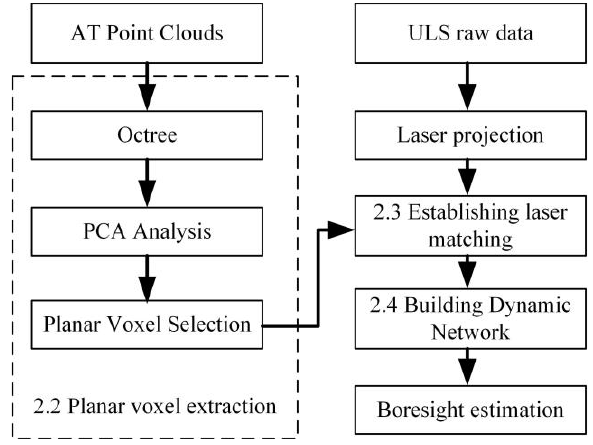
Fig.1 Workflow the proposed method.